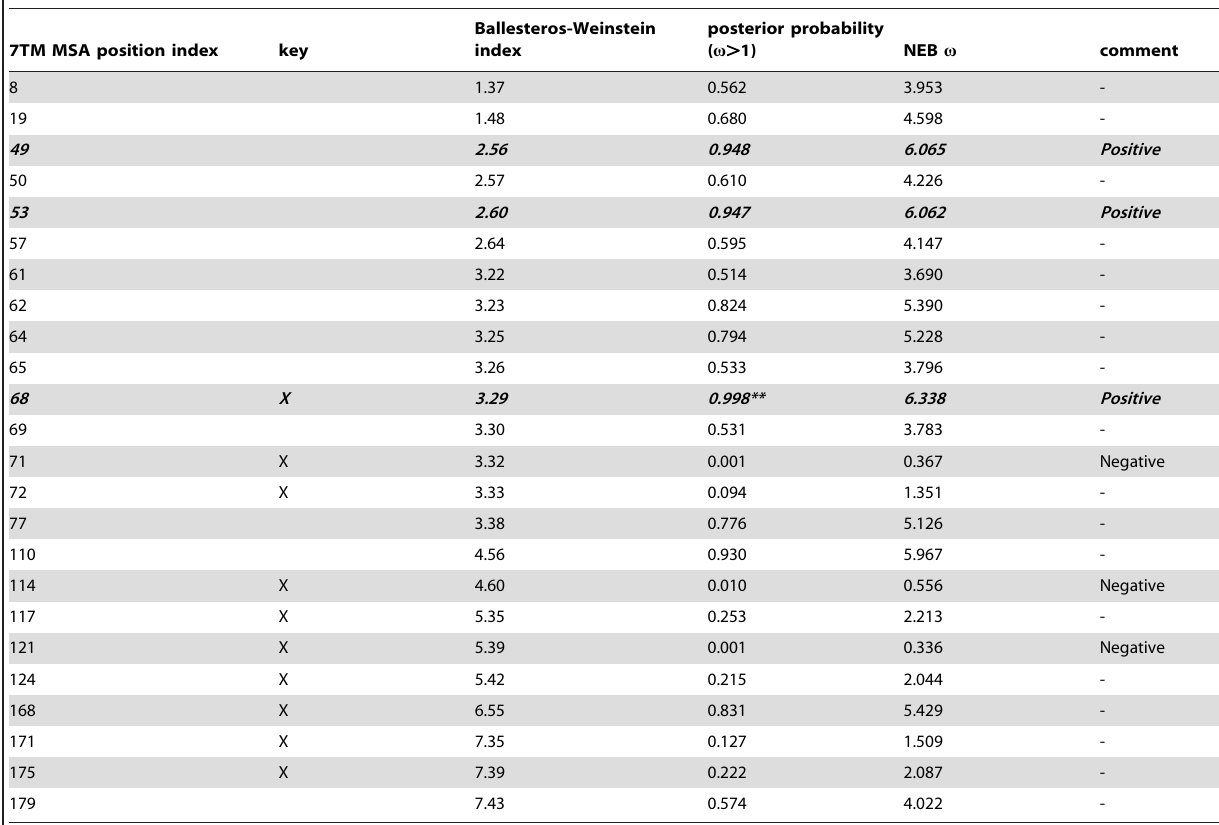
Table 6. v for subgroup